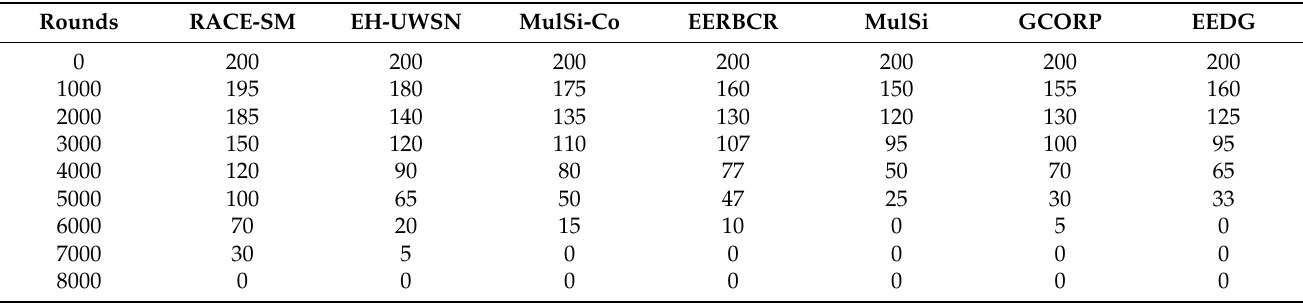
Table 5. Addressing the Number of Alive Nodes.